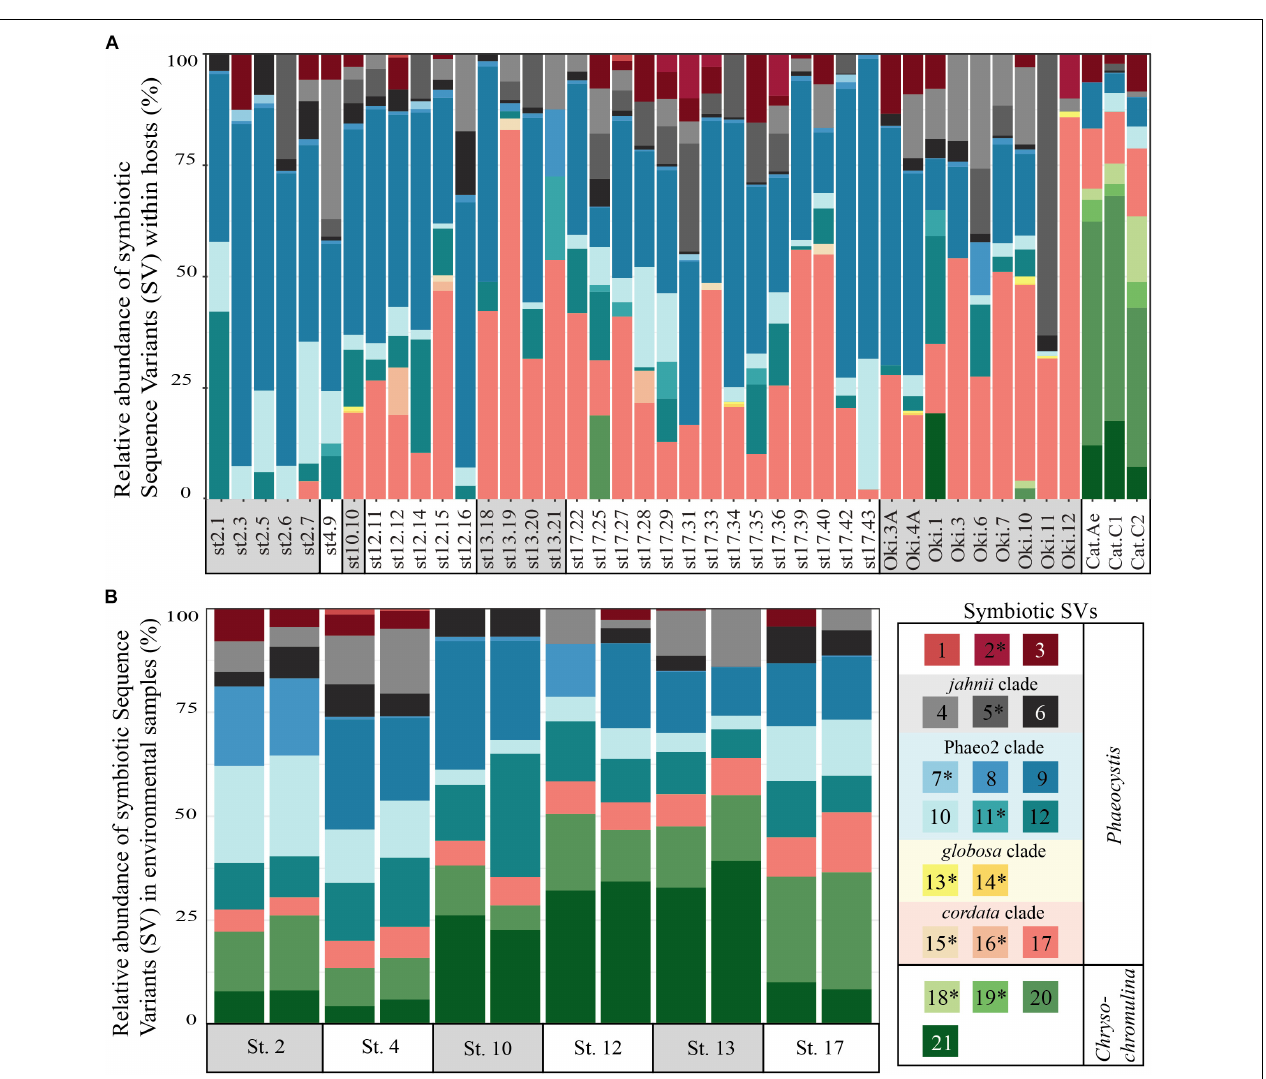
FIGURE 1 | Relative abundance of symbiotic Sequence Variants (SVs) in individual acantharian hosts (A) and environmental samples (B) . (A) Each bar represents a single acantharian host and is labeled by collection location (st#, ECS cruise station number; Oki, Okinawa Island; Cat, Catalina Island) and sample ID. Individual acantharians contained 4–12 symbiotic SVs (mean = 8, SD = 2). (B) Each bar represents an environmental replicate from ECS cruise stations. Symbiotic SVs are colored by clade: green is Chrysochromulina , blue is Phaeocystis clade Phaeo2, pink is Phaeocystis cordata , gray/black is Phaeocystis jahnii , and purple is Phaeocystis , but not placed within known clades. Ten of the symbiotic SVs were not found in environmental samples and are marked by an asterisk in the legend. The figure was created with R package